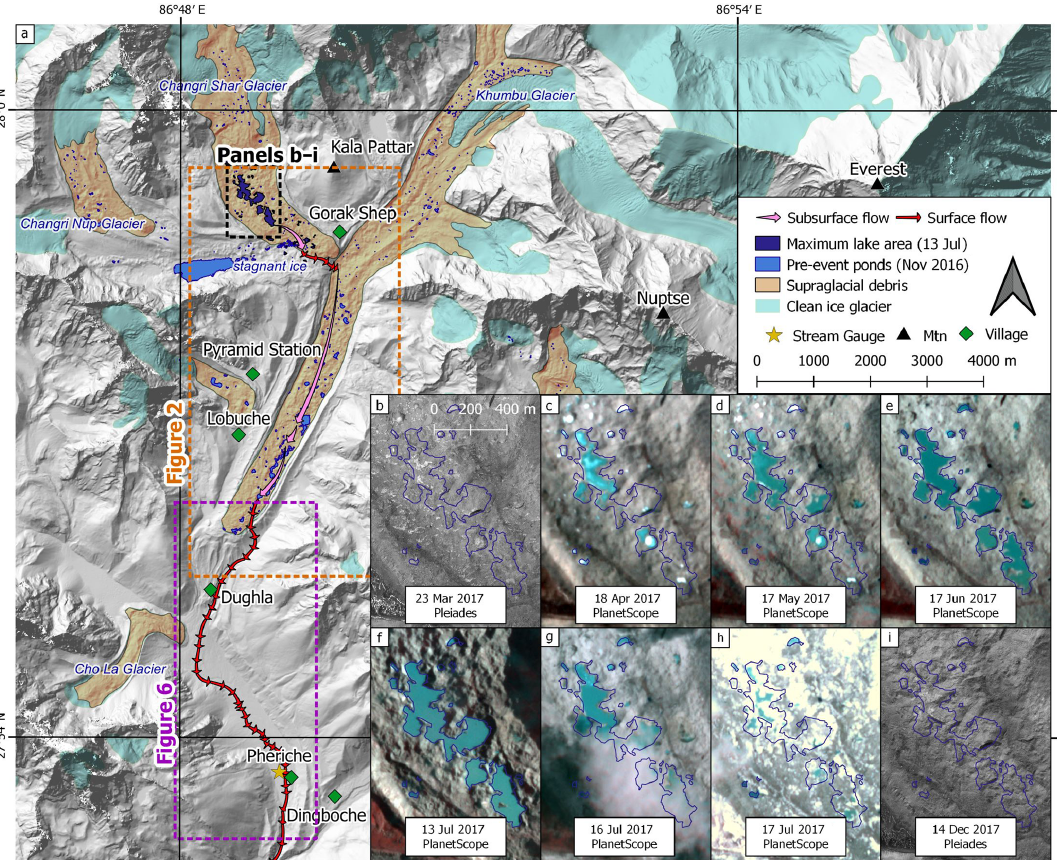
Figure 1. The study area and interpreted flow path through Changri Shar and Khumbu glaciers (a) . The expansion and drainage of the Changri Shar supraglacial lake in 2017, denoting maximum observed lake area with an outline (b–i) . The debris-covered glacier area was delineated manually with respect to the March Pléiades imagery and modified from the RGI 6.0 (Pfeffer et al., 2014). The background hillshade is derived from the High Mountain Asia DEM mosaic (Shean,